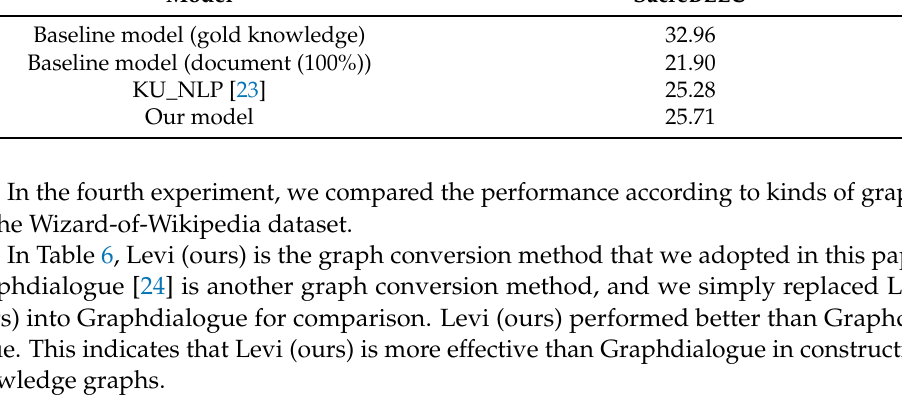
Table 6. Performance comparison according to kinds of graphs on the Wizard-of-Wikipedia dataset. Graph Representation BLEU-1 Graphdialog [24]